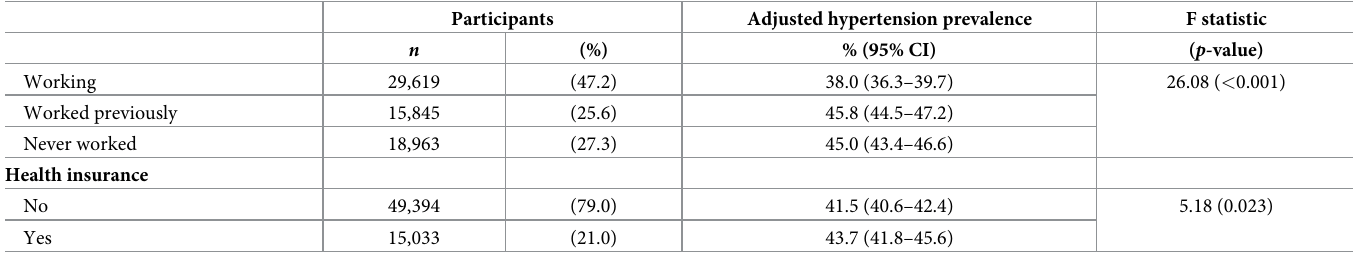
Table 3 shows adjusted percentages of adults aged 45 years and over and their spouses with hypertension who (a) were aware of their condition; (b) were under treatment for it; and (c) had their BP under control. Overall, we estimated that 54.4% (95% CI 53.1 to 55.7) were aware, 50.8% (95% CI 49.5 to 52.0) were treated, and only 28.8% (95% CI 27.4 to 30.1) had achieved control. There was an 18 percentage points (pp) gap between the richest fifth and the poorest fifth in awareness. The rich–poor gaps were 19 pp and 13 pp for treatment and control, respectively. Concentration indices for ATC were all positive: 0.072 (95% CI 0.056 to 0.089), 0.077 (95% CI 0.061 to 0.093), and 0.055 (95% CI 0.043 to 0.067), respectively (Table 2). This confirmed pro-rich inequalities in hypertension ATC. Gaps between the most and least edu- cated groups were 18 pp, 19 pp, and 13 pp for rates of hypertension ATC, respectively. Among those with hypertension, males were less likely than females to be aware, treated, and controlled. Rates of ATC were also lower for scheduled tribes, rural dwellers, the were less likely to have been diagnosed and treated, but they were not less likely to have